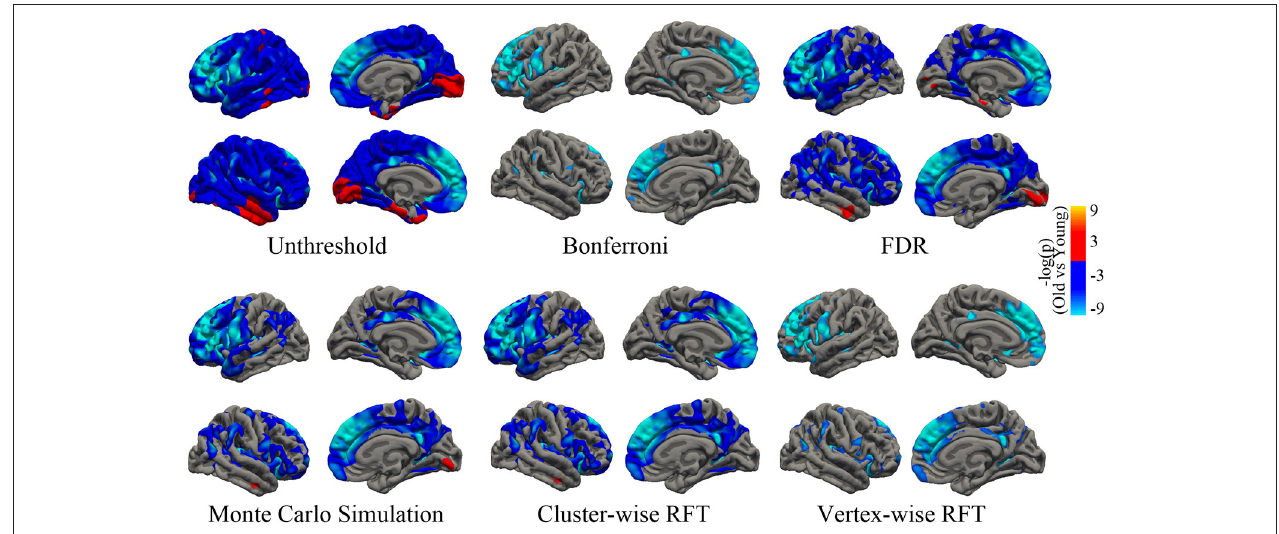
FIGURE 7 | Unthresholed statistical map and thresholded maps using bonferroni, FDR, Monto Carlo simulation, cluster-wise/vertex-wise random field theory. The corrected statistical level was p < 0.05. The cluster-forming threshold was p < 0.001. Regions with blue/red color indicate deceased/increased thickness in old adults, respectively. FDR, false positive rate.